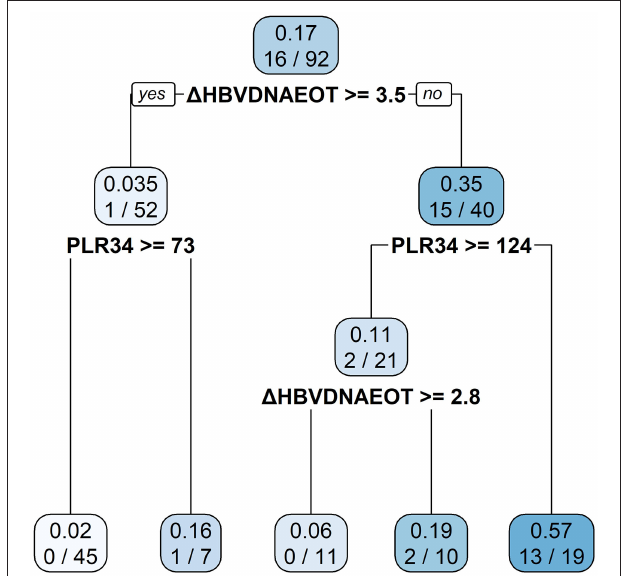
FIGURE 4 | A decision tree for the non-rebound outcome predictive model. The decision tree consists of a root node, an internal node, and a leaf node, which are represented as squares. The darker the square, the higher probability of non-rebound will be